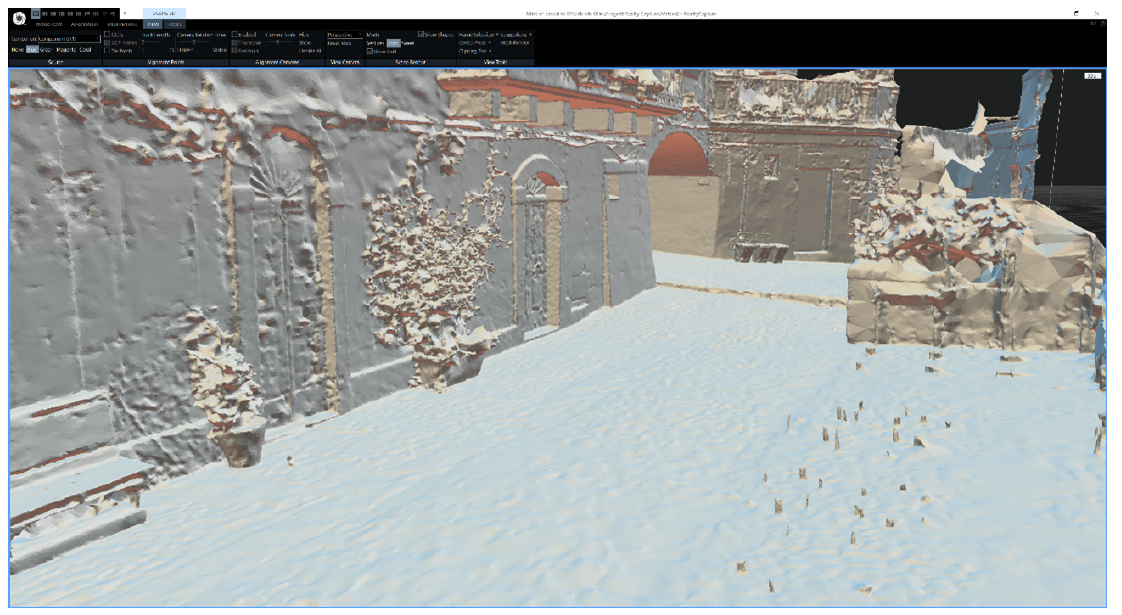
Figure 3. RealityCapture user interface showing the reconstructed mesh.